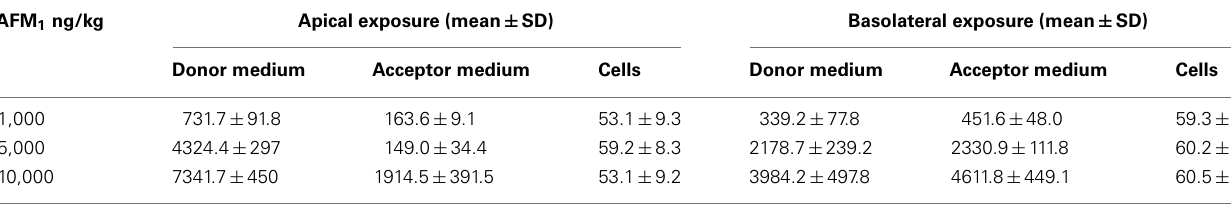
Table 1 |AFM 1 detection in donor compartment, acceptor compartment, and cellular fractions after exposure for 48h. AFM 1 ng/kg